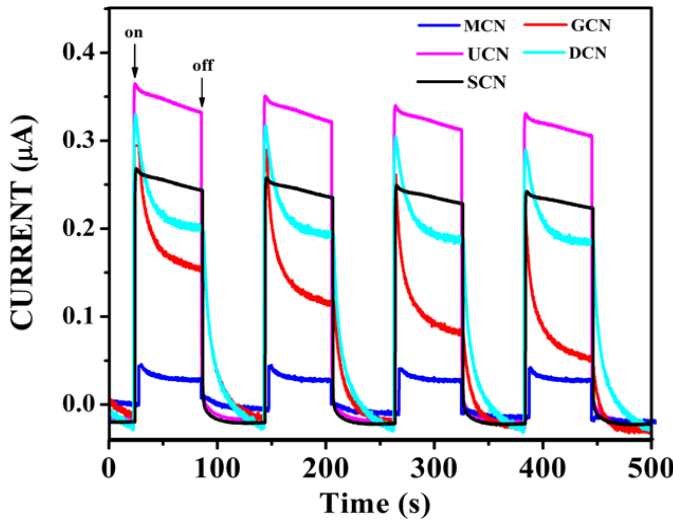
Figure 4. Photocurrent curves on the MCN, DCN, GCN, SCN and UCN samples.